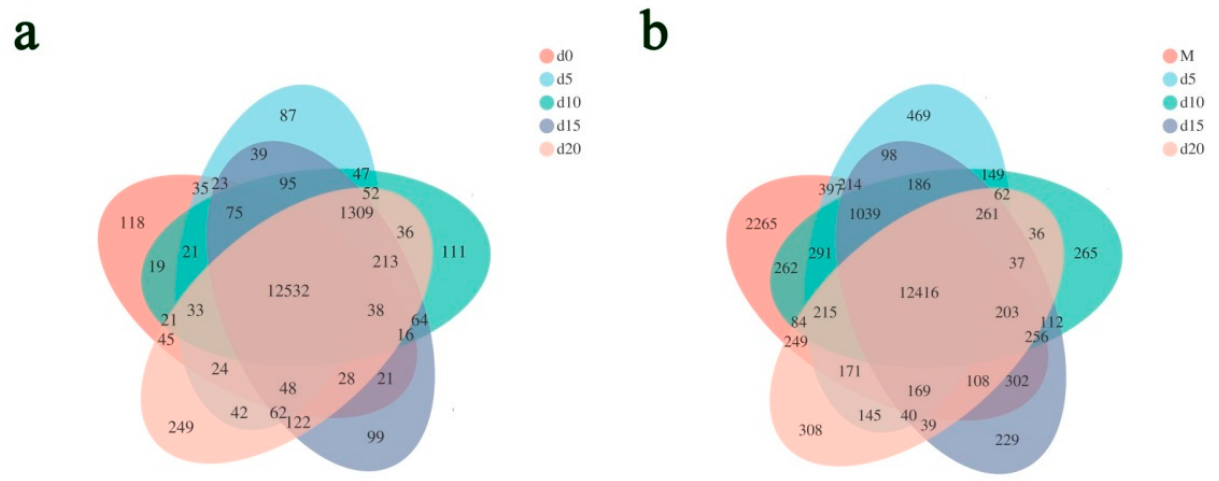
Figure 2. Venn diagrams of the expressed gene numbers on the initial (d0 or M), 5th (d5), 10th (d10), 15th (d15), and 20th (d20) days of the coculture. ( a ) Gastrodia elata ; ( b ) Mycena sp. WM.